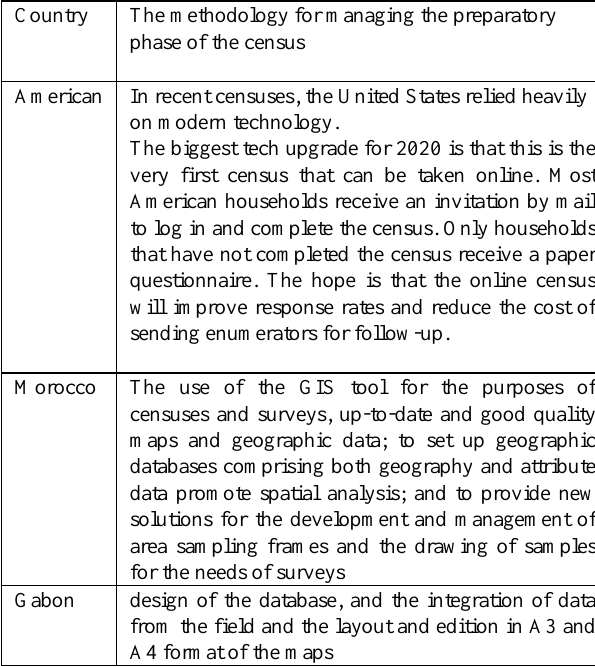
Figure 7. Representation of Population